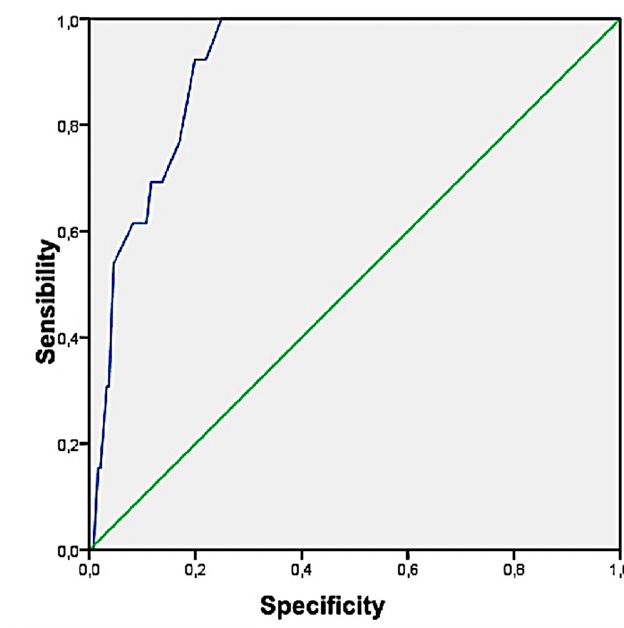
Figure 5. NCEP-ATPIII according to Model 1.